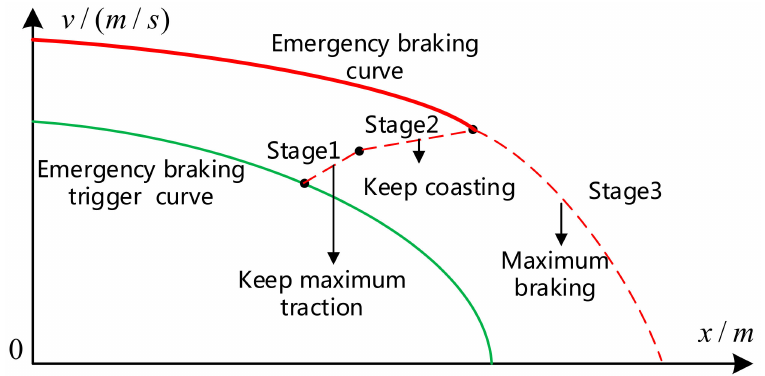
Figure 7. Three stages in emergency braking intervention (EBI) protection.